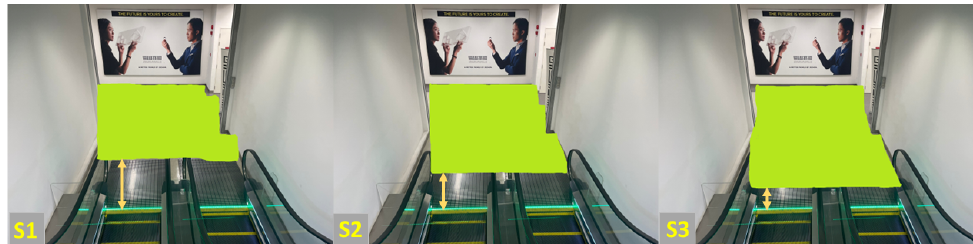
Figure 12. Generated track map after each trail from various starting points (S1 starting point 1, S2 starting point 2, and S3 starting point 3) near escalator of scenario-1 descending direction wherein the green pixels represents the robot-covered region, and yellow arrow represents the distance between the covered region and escalator’s first